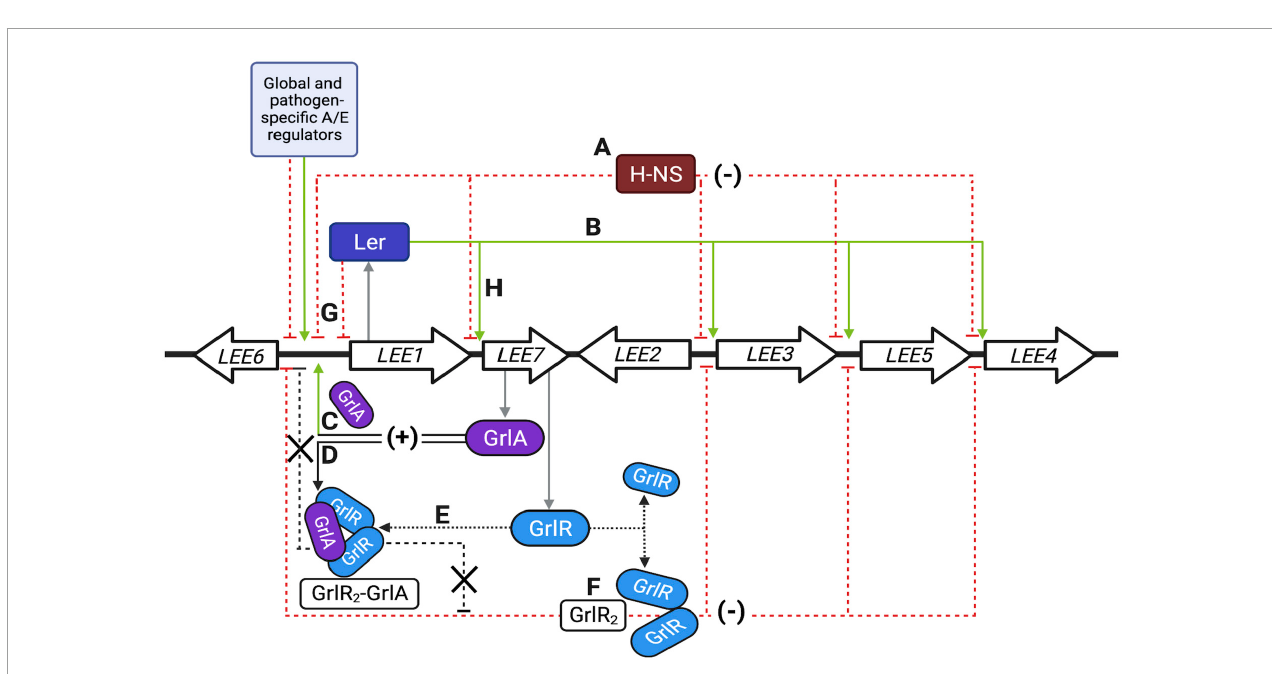
FIGURE10 Schematic representation of the locus of enterocyte effacement (LEE) regulatory network. (A–H) Represent the primary regulatory circuits controlling LEE gene expression, as described in detail in the discussion. Green and red dashed lines indicate positive and negative regulatory pathways; black arrows indicate protein interactions. Thick arrows show a simplified representation of the seven operons previously reviewed in detail (Gaytan et al., 2016). Single genes are not illustrated. The first gene of the polycistronic LEE1 operon encodes Ler, while the bicistronic LEE7 operon codes for GrlR and GrlA. The light blue box represents several other global, ancestral and pathotype-specific regulators that modulate LEE gene expression, mainly by acting, but not exclusively, on Ler expression. Other colleagues have extensively and elegantly reviewed the regulatory elements known to modulate the regulation of the LEE (Furniss and Clements, 2018; Platenkamp and Mellies, 2018; Turner et al., 2019; Serapio-Palacios and Finlay, 2020). Created with